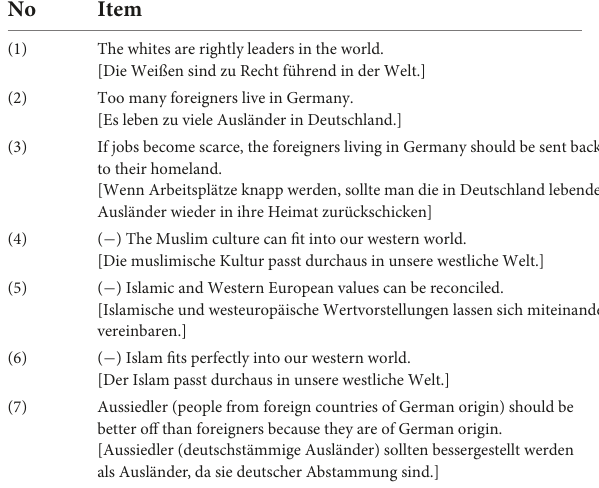
TABLE 3 Items for attitude toward group.